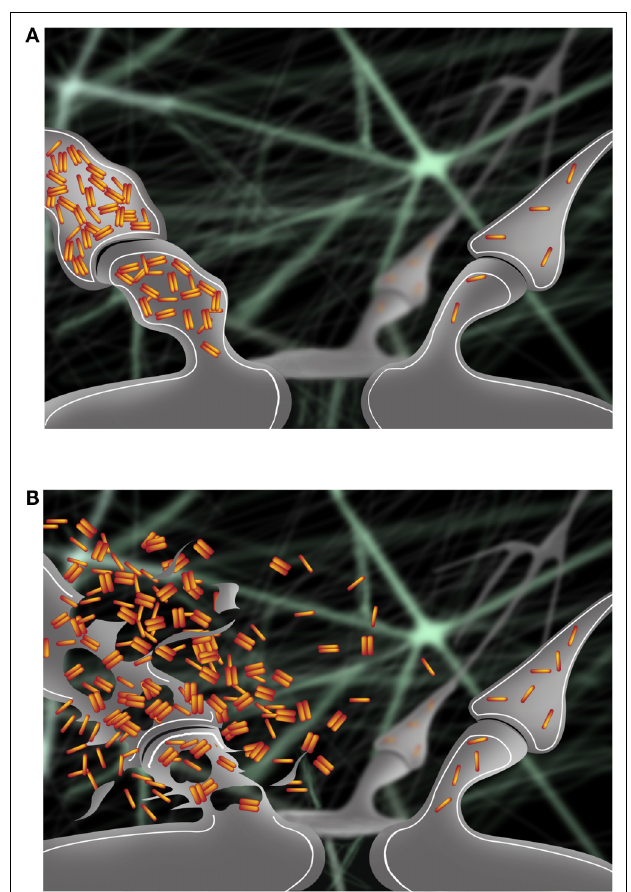
FIGURE 1 | (A) Accumulation of intraneuronal A β 42 at early stages of AD occurs progressively in a synapse (left) and is associated with pathological alterations compared to a normal synapse (right). (B) Intraneuronal A β 42 is released in the extracellular space following degeneration of the synapse (left). Release of intraneuronal A β 42 into the extracellular space may contribute to the toxic spread of A β pathology to a nearby synapse